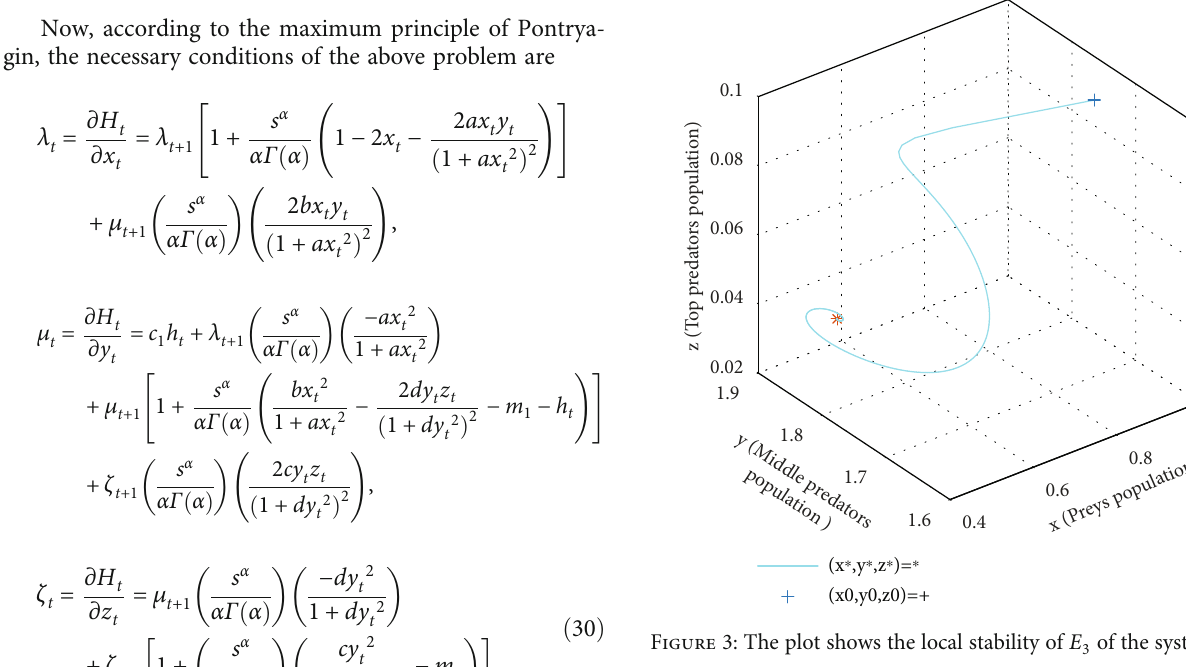
3 of the system (8).